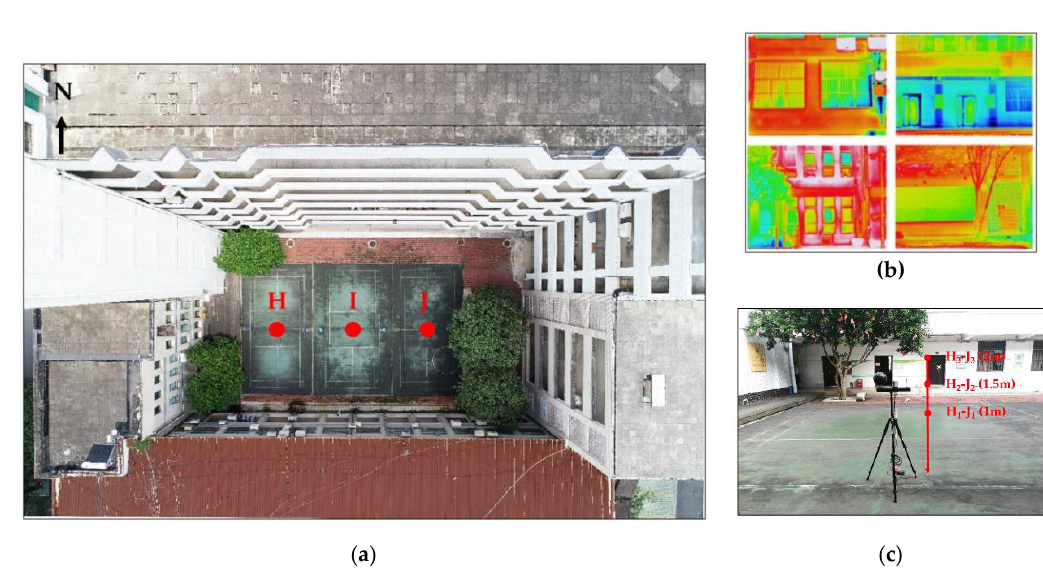
Figure 10. Locations of measurement points and thermal images in the enclosed courtyard. ( a ) Measurement points H, I, J; ( b ) thermal images of surrounding surfaces in the courtyard, taken in daytime on a sunny day; ( c ) globe thermometer (measurement instrument).